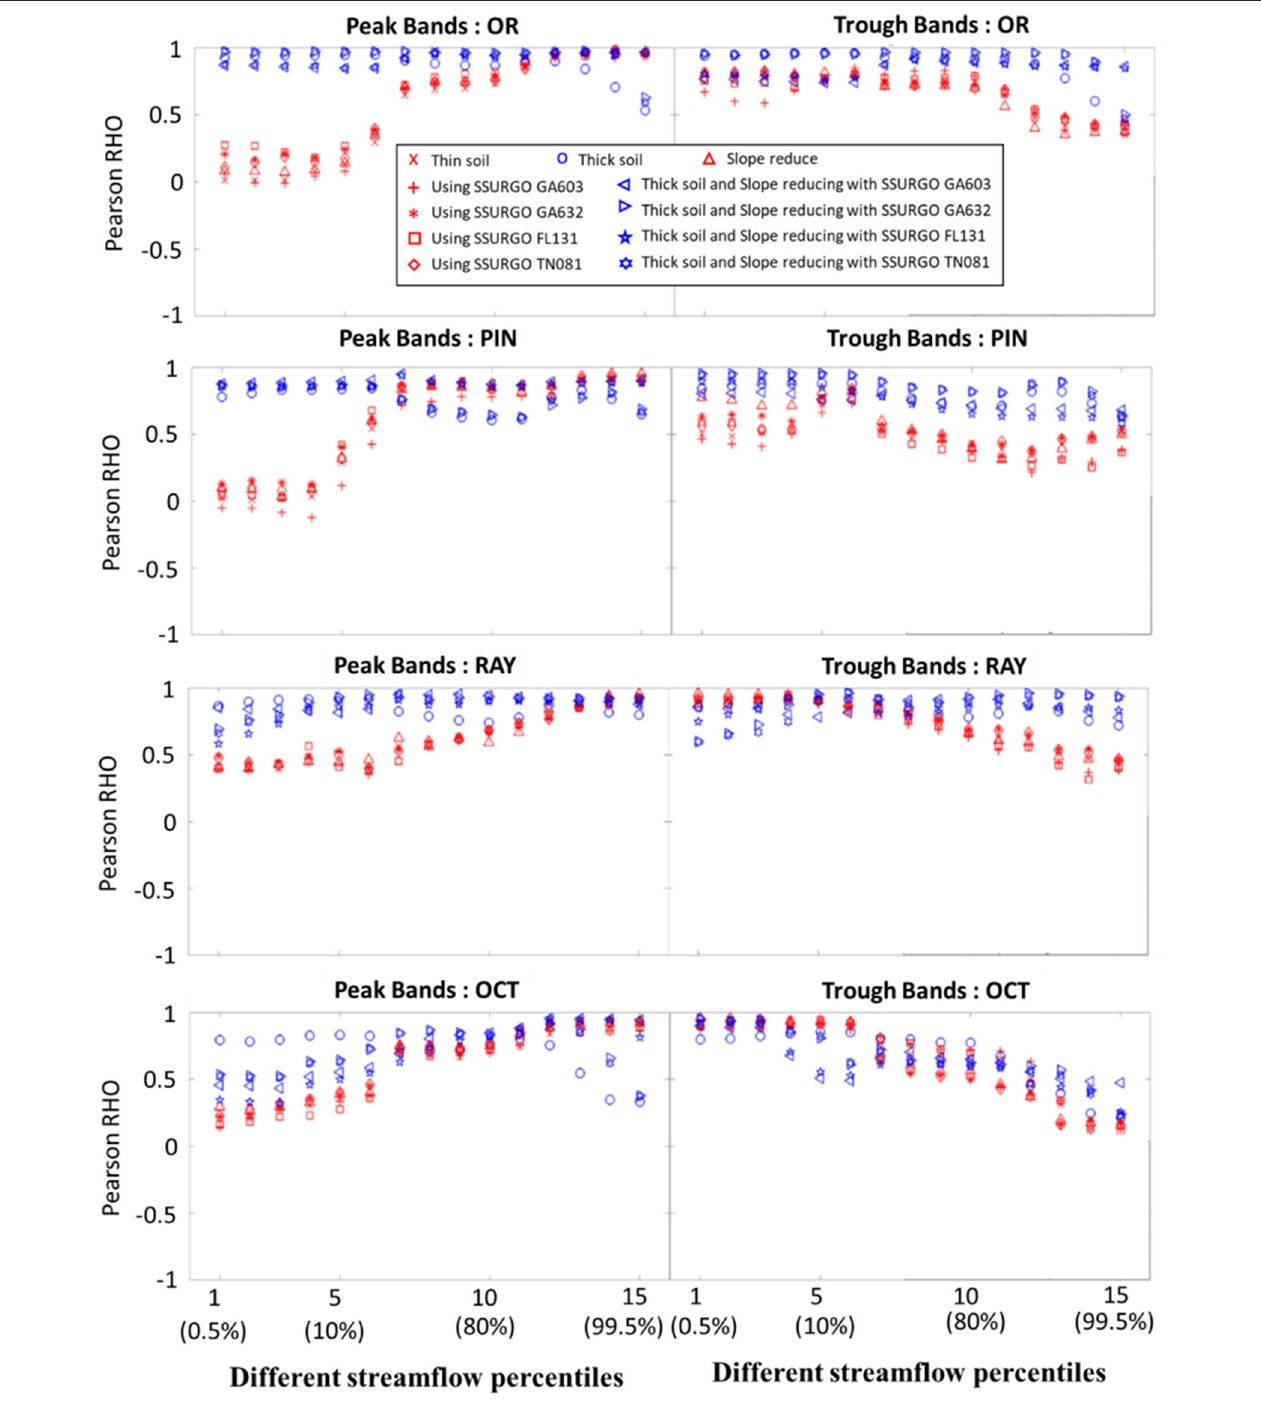
FIGURE 6 | SSCS extracted from the numerical experiments. “Thin soil” is the default simulation with SRB-default parameters.